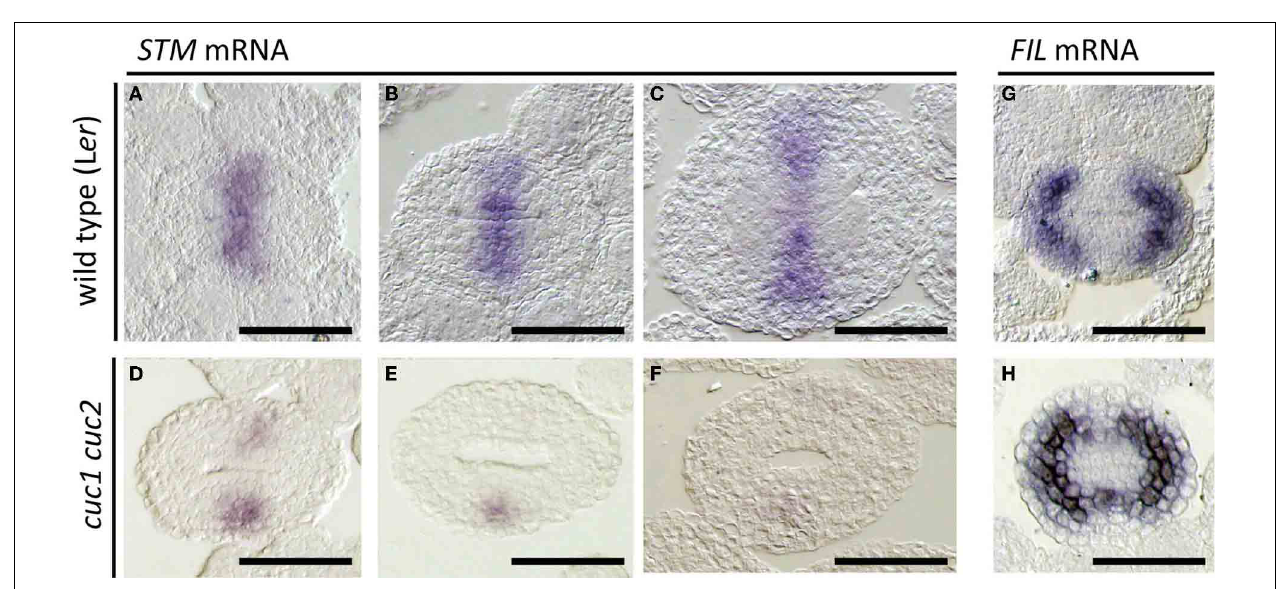
FIGURE 4 | Effect of cuc1 cuc2 on STM and FIL expression. In situ hybridization on transverse sections of developing wild type L er (A–C,G) and cuc1 cuc2 (D–F,H) gynoecia regenerated from calli. Probed with